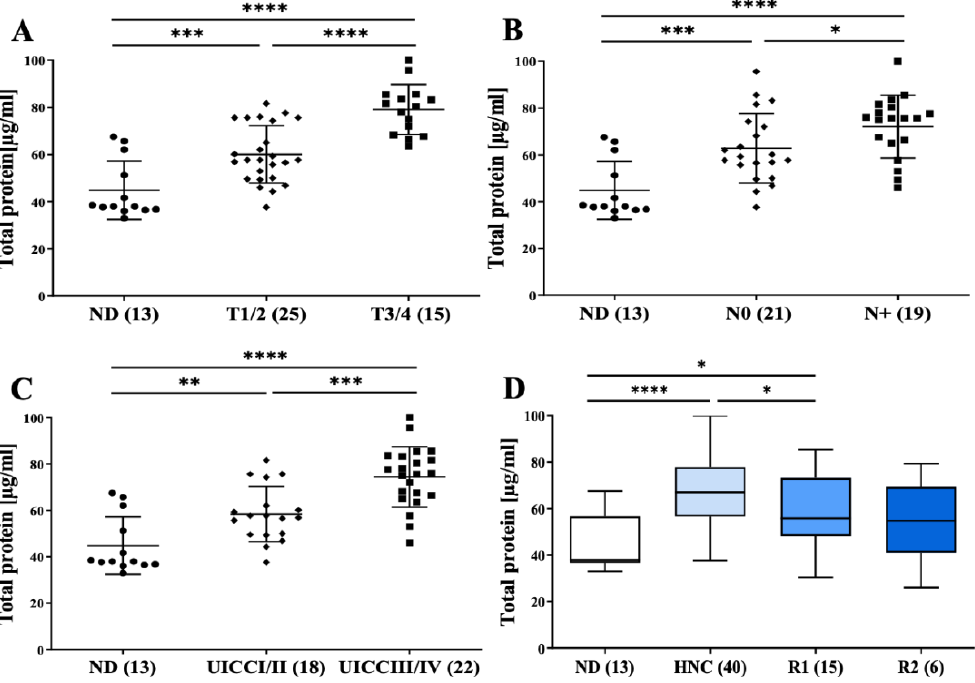
Figure 2. The total protein content of plasma sEV preparations as an indicator of progressed disease and therapy response. The total sEV protein content (of unconcentrated samples) is significantly higher in HNC patients than NDs and increases with ( A ) bigger tumor size, ( B ) positive nodal status and ( C ) advanced tumor stage. ( D ) The decrease in protein content indicates response to therapy. ND: normal donor; HNC: HNC patient; R1: patients after 3 months-follow-up; R2: patients after 6 months follow-up. p < 0.05 was considered significant. (* p < 0.05; ** p < 0.01, *** p < 0.001, **** p <